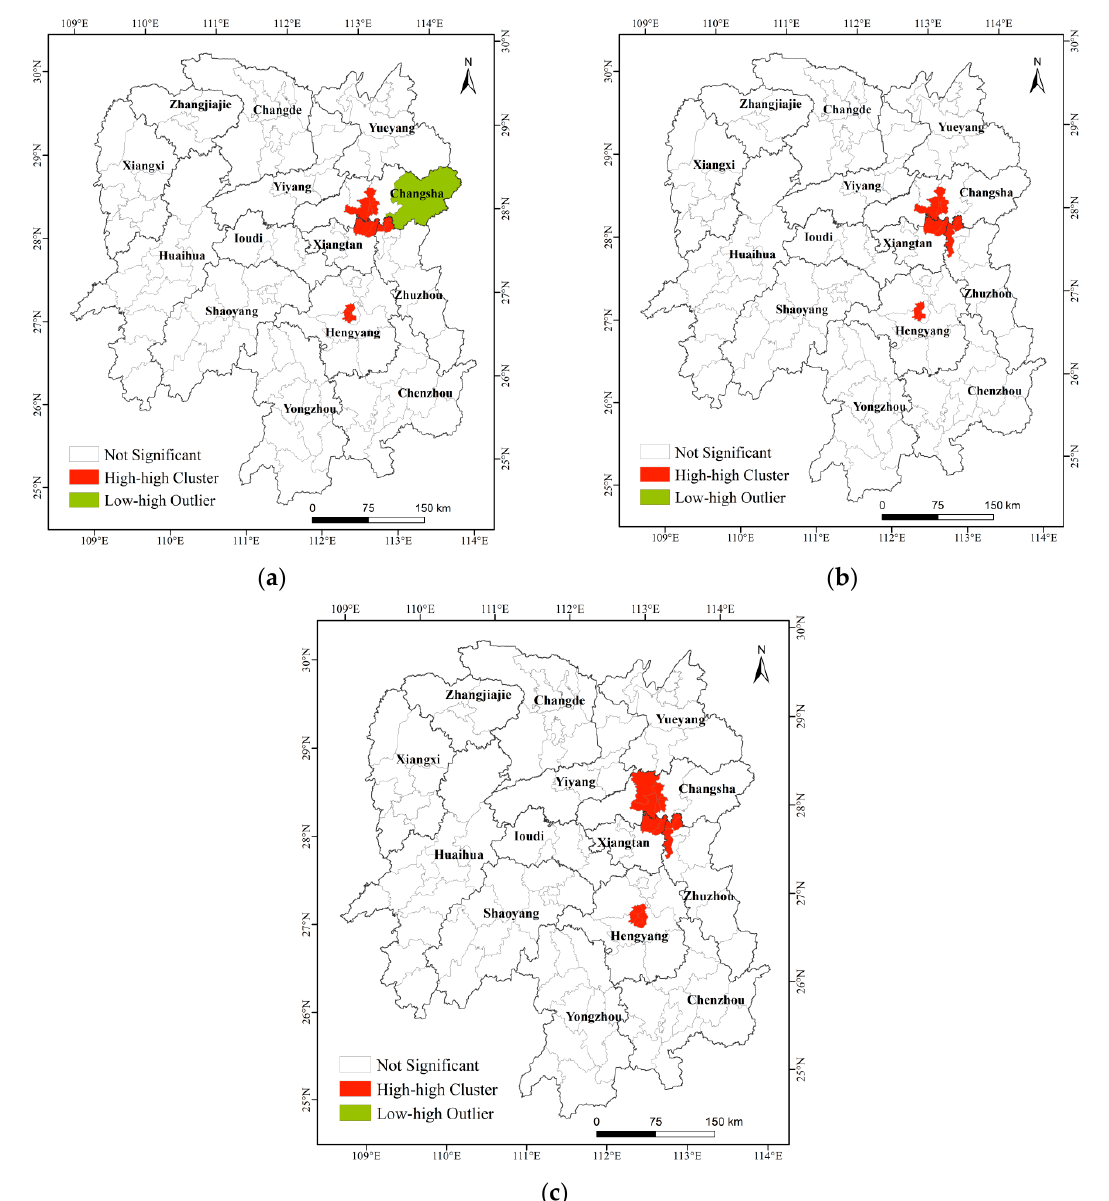
Figure 7. ( a – c ) are the local spatial autocorrelation results of the SDG 1 evaluation value in Hunan Province in 2014, 2016 and 2018, respectively.